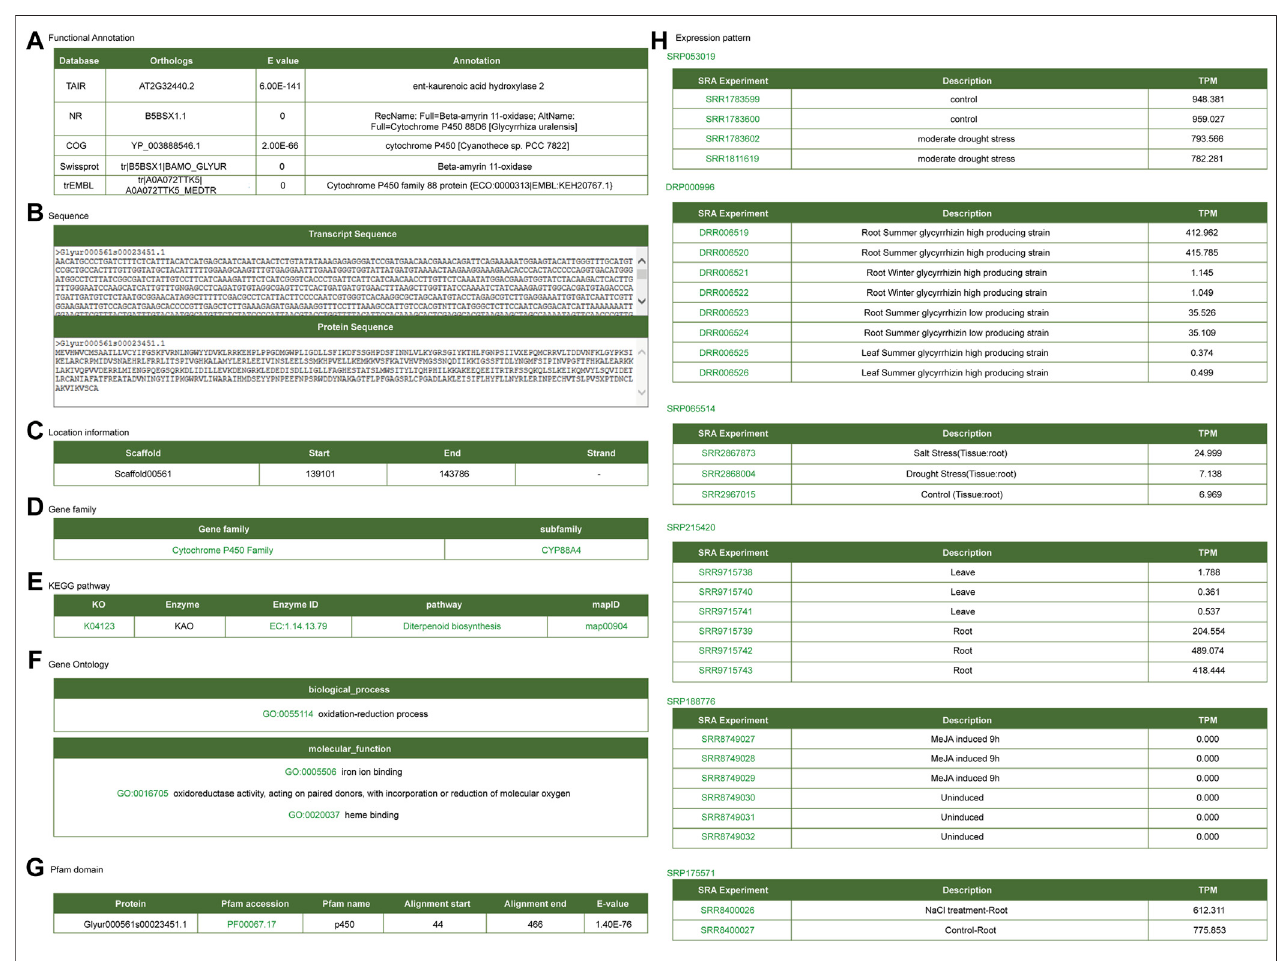
FIGURE4| Genedetailinterfaceof CYP88D6 gene. (A) Functionalannotation. (B) Transcriptandproteinsequence. (C) Genelocationinformation. (D) Genefamily. (E) KEGG signal pathway. (F) GO annotation. (G) Protein domain. (H) Expression level in different RNA-seq samples.